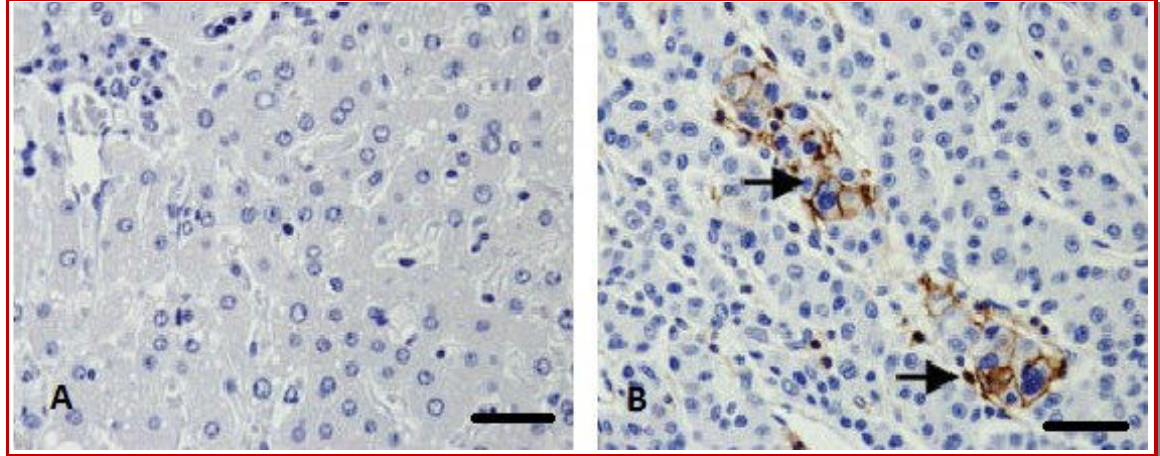
Figure 1: Immunohistochemistry analysis. A. Normal liver tissue samples show no CD90 + cells. B. Liver cancer tissue samples show CD90 + cells as mentioned in the figure with arrow mark. The CD90 + cells are brown in color after staining it with